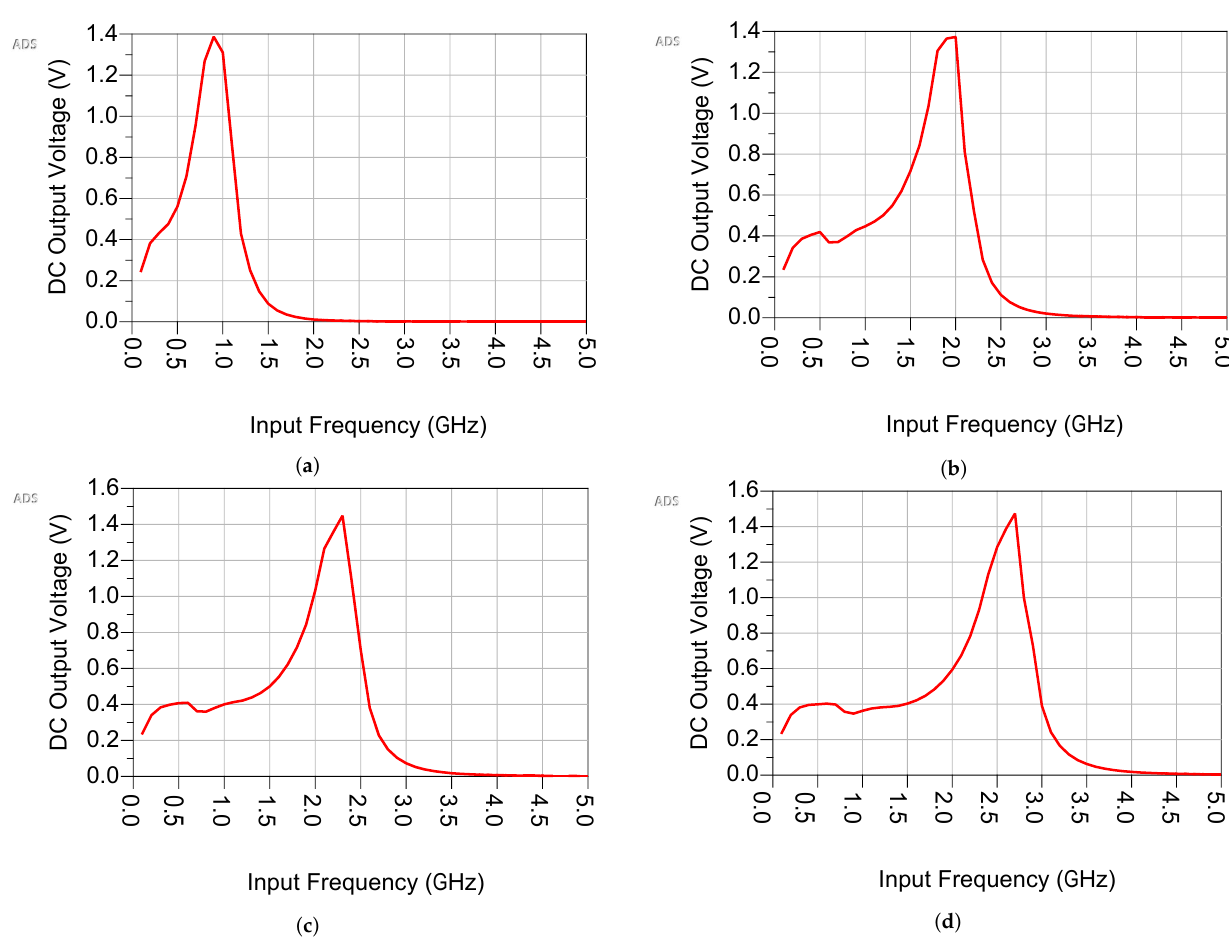
Figure 18. Output voltage of each channel under 0 dBm input power. ( a ) GSM-900. ( b ) GSM-1800. ( c ) UMTS-2100. ( d ) Wi-Fi 2.45.